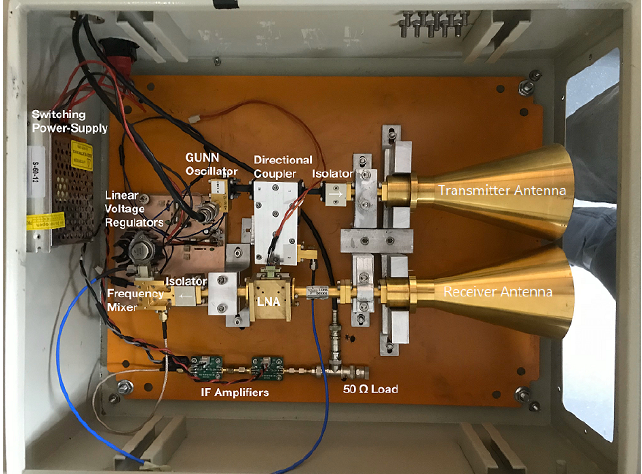
Figure 4. The actual radar. In the image, it is possible to see the power supply and the Transmitter and Receiver chains. The container box is a conductor which is usually employed in the implementation of electrical panels. It serves as a structure to attach the components and also provides protection from the environment during field campaigns. During operation, the aperture in front of the antennas is covered with a material that is practically transparent within the